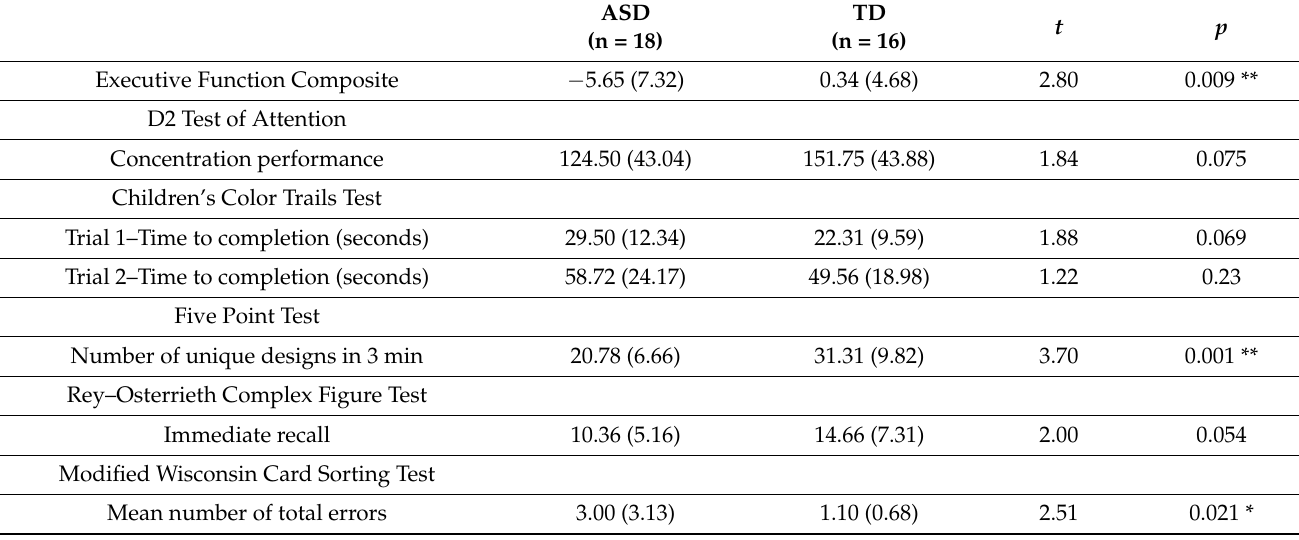
Table 2. Comparison of mean scores in executive function tasks between children with autism (ASD) and typically developing (TD)